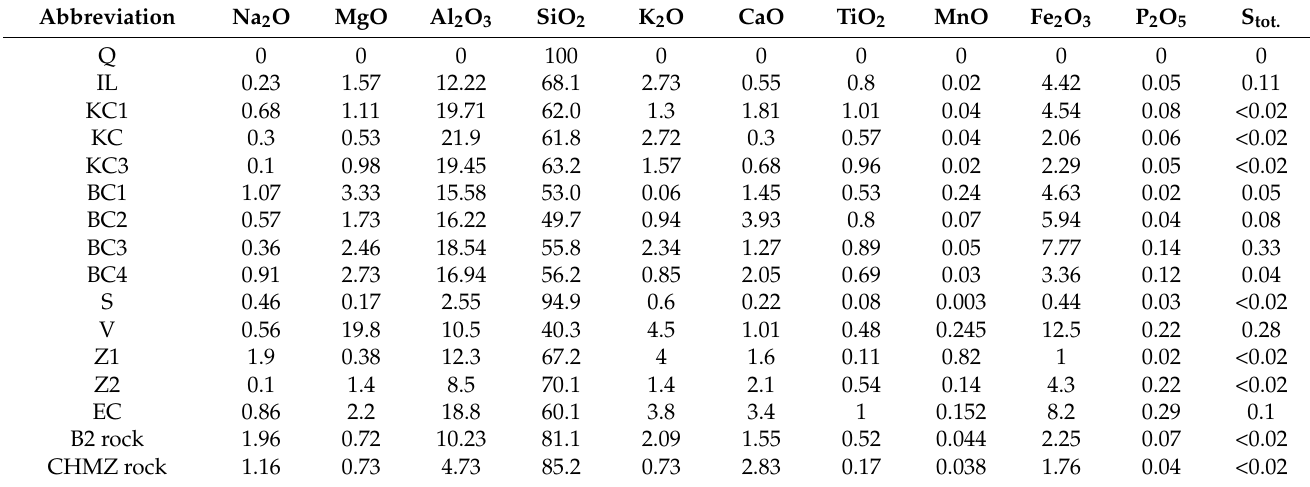
Table 3. Elemental composition of the mineral carriers, %